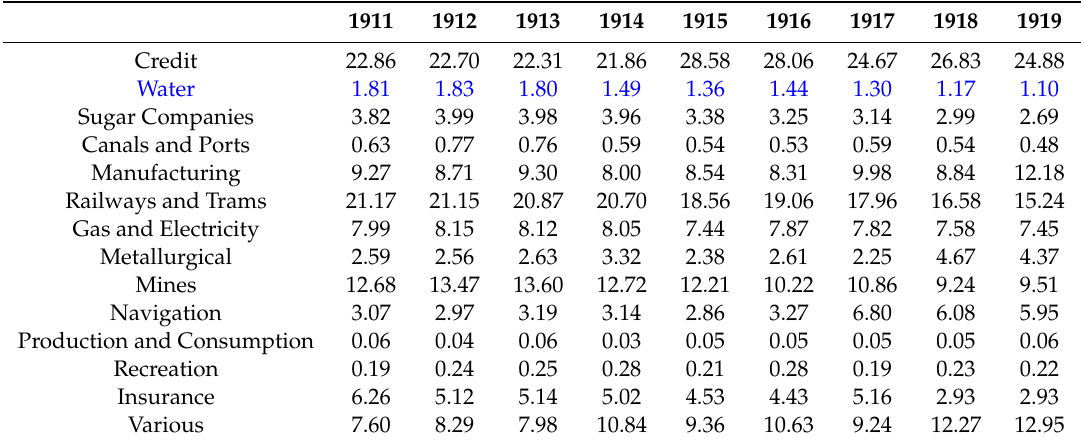
Table 4. Percentage distribution of the capitals of the di ff erent sectors between 1911 and